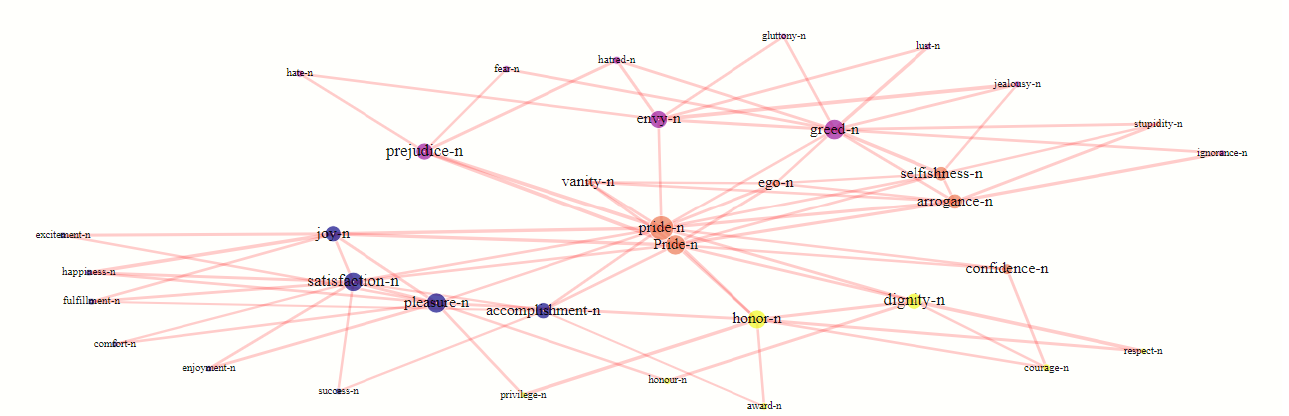
Figure 2. Representation of a second order clustered coordination based lexical graph of a seed lexeme pride-n : 143 nodes, 192 edges, 9 clusters; parameters: corpus = ententen13, n = 15, clustering = leiden , partition = mvp .